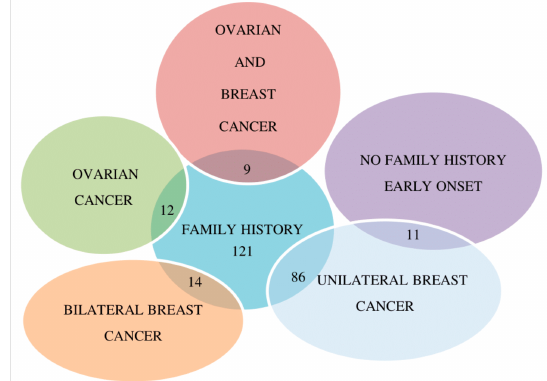
Figure 1. Venn’s diagram regarding the kind of studied